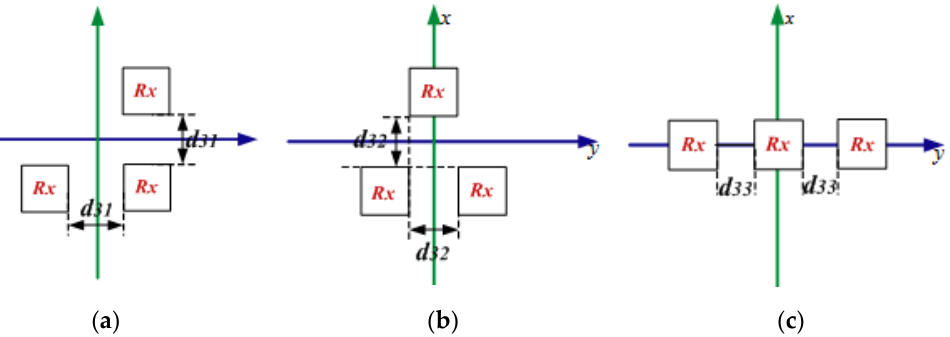
Figure 6. The Rx coils are in different topology positions of the STTR WPT system. ( a ) Case 0. ( b ) Case 1. and ( c ) case 2.